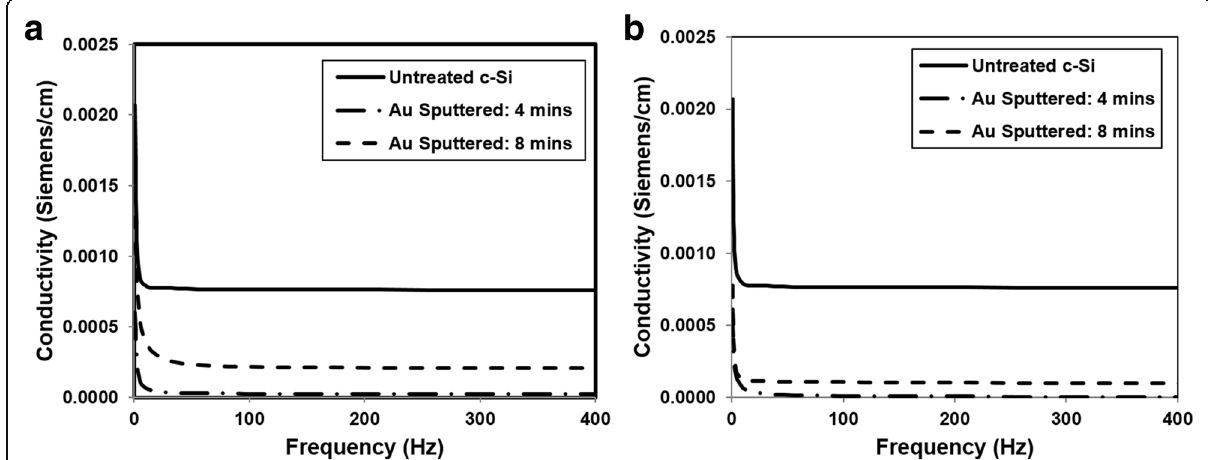
Fig. 13 The total conductivity of gold sputtered silicon samples. a 1 OL, b 2 OL (higher conductivity of untreated silicon is due to its zero porosity)